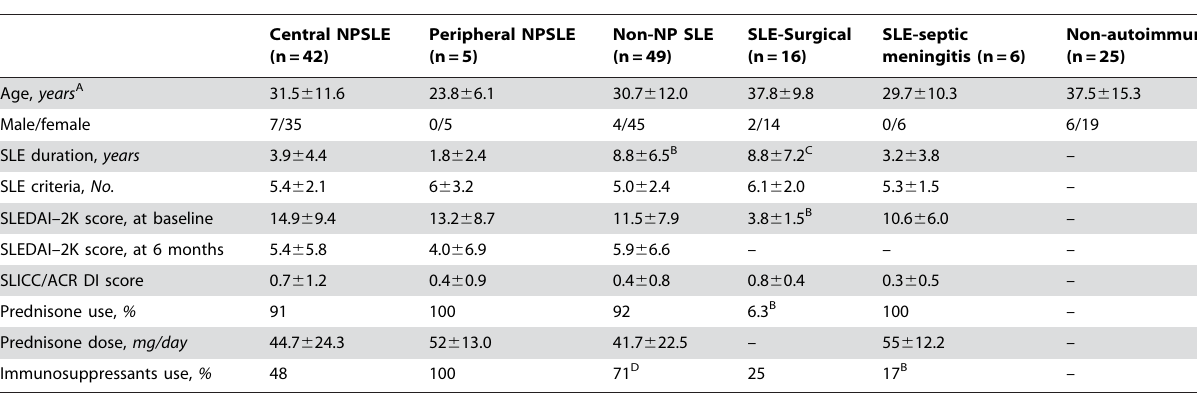
Table 1. Demographic and clinical characteristics of the study patients at